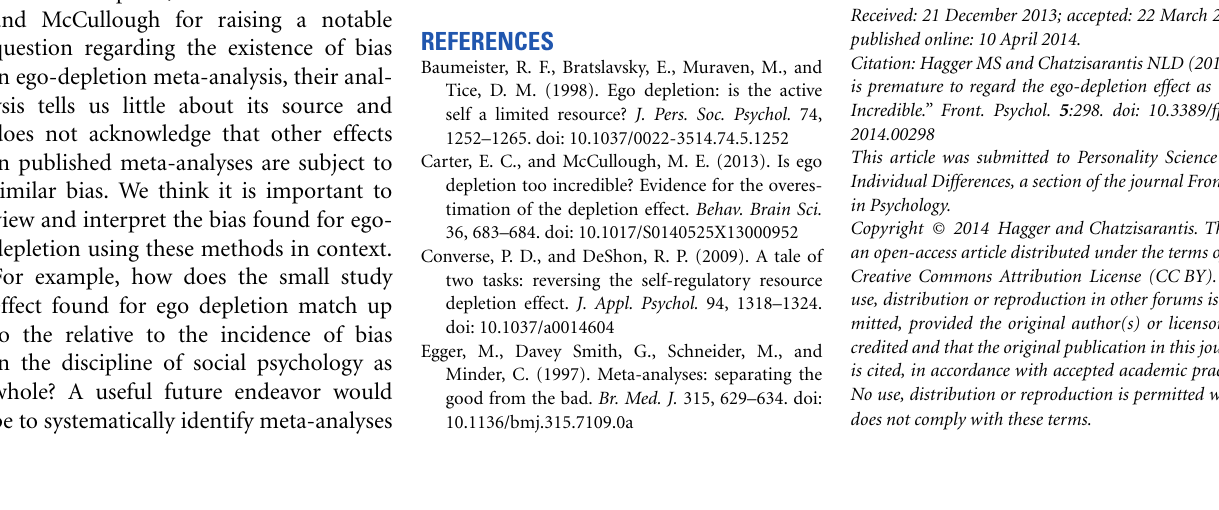
Figure S1 | Funnel plot of the ego-depletion effect size (standardized mean difference, Cohen’s d) against the study precision (1/standard error). Figure S2 | Funnel plot of the ego-depletion effect size (standardized mean difference, Cohen’s d) against the standard error of the effect